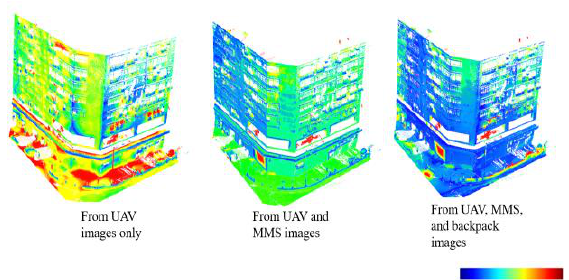
Figure 8. Unsigned CMD of a typical building façade based on the model from UAV images only, UAV and MMS images, and UAV, MMS, and backpack images.